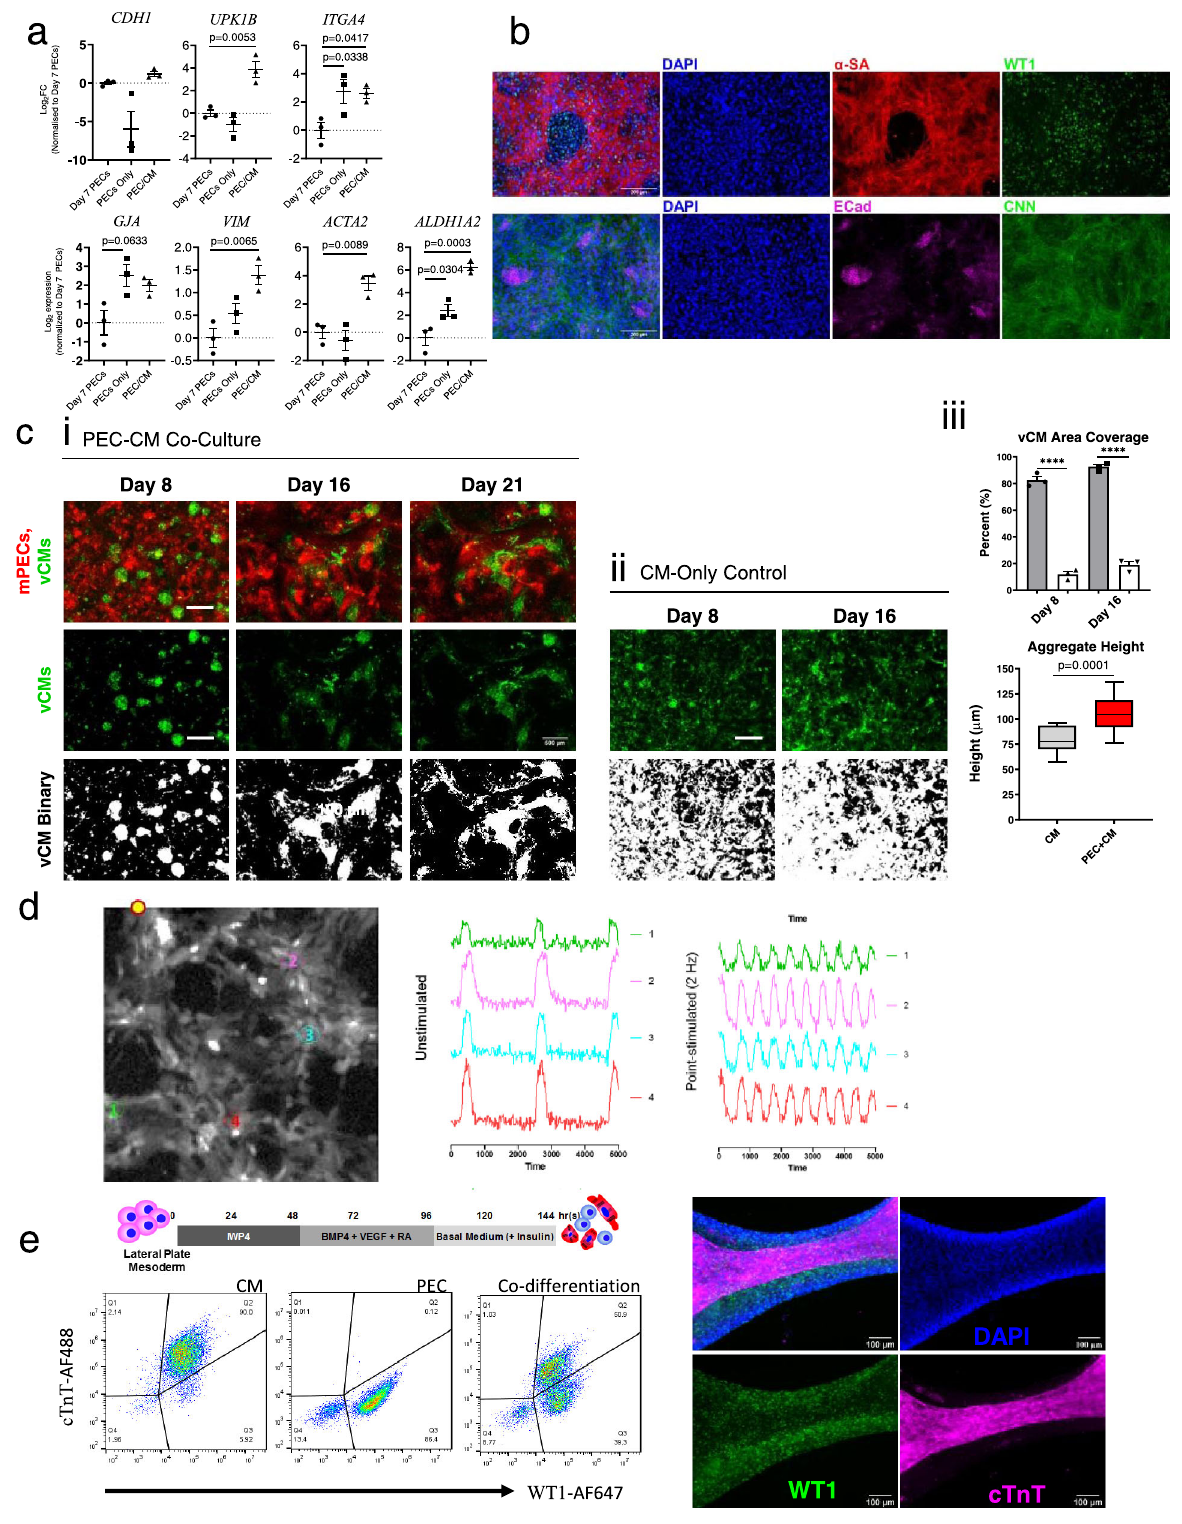
more ventricular-like identity 43 . Consistent with our earlier fi nding, PEC co-culture caused network formation of CMs after 6 days (Supplementary Movie 5), and cTnT + EdU + cells were signi fi cantly increased (37.2 ± 2.1%) vs. control CMs without PEC co-culture (28.1 ± 1%, p = 0.016; Fig. 6c, d).